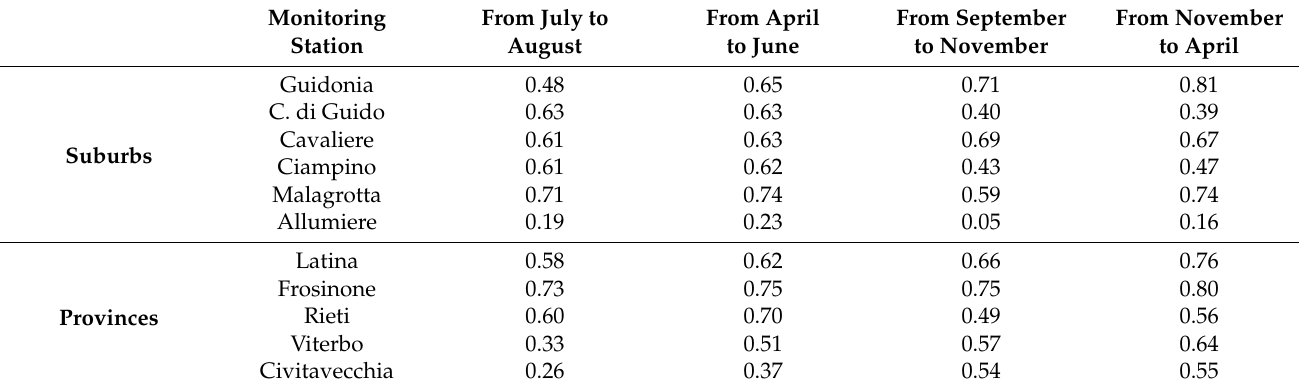
Table 8. Cross-correlation values between Roma Green Band and suburbs or province stations of [NO] in 2015.